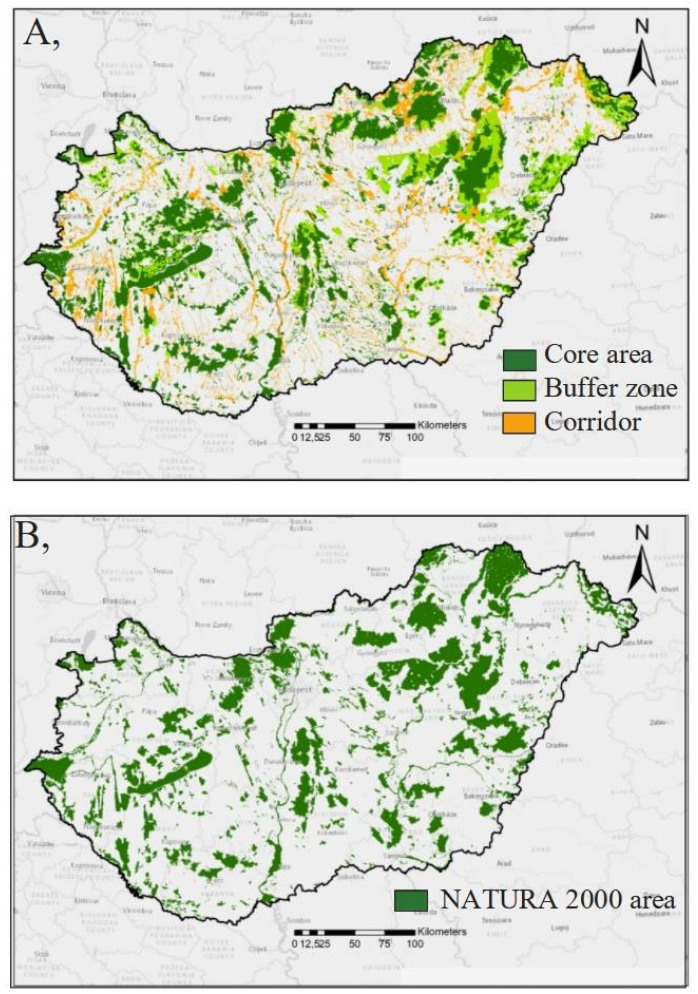
Figure 2. Spatial structure of the HEN ( A ) and Natura 2000 network ( B ) in Hungary.